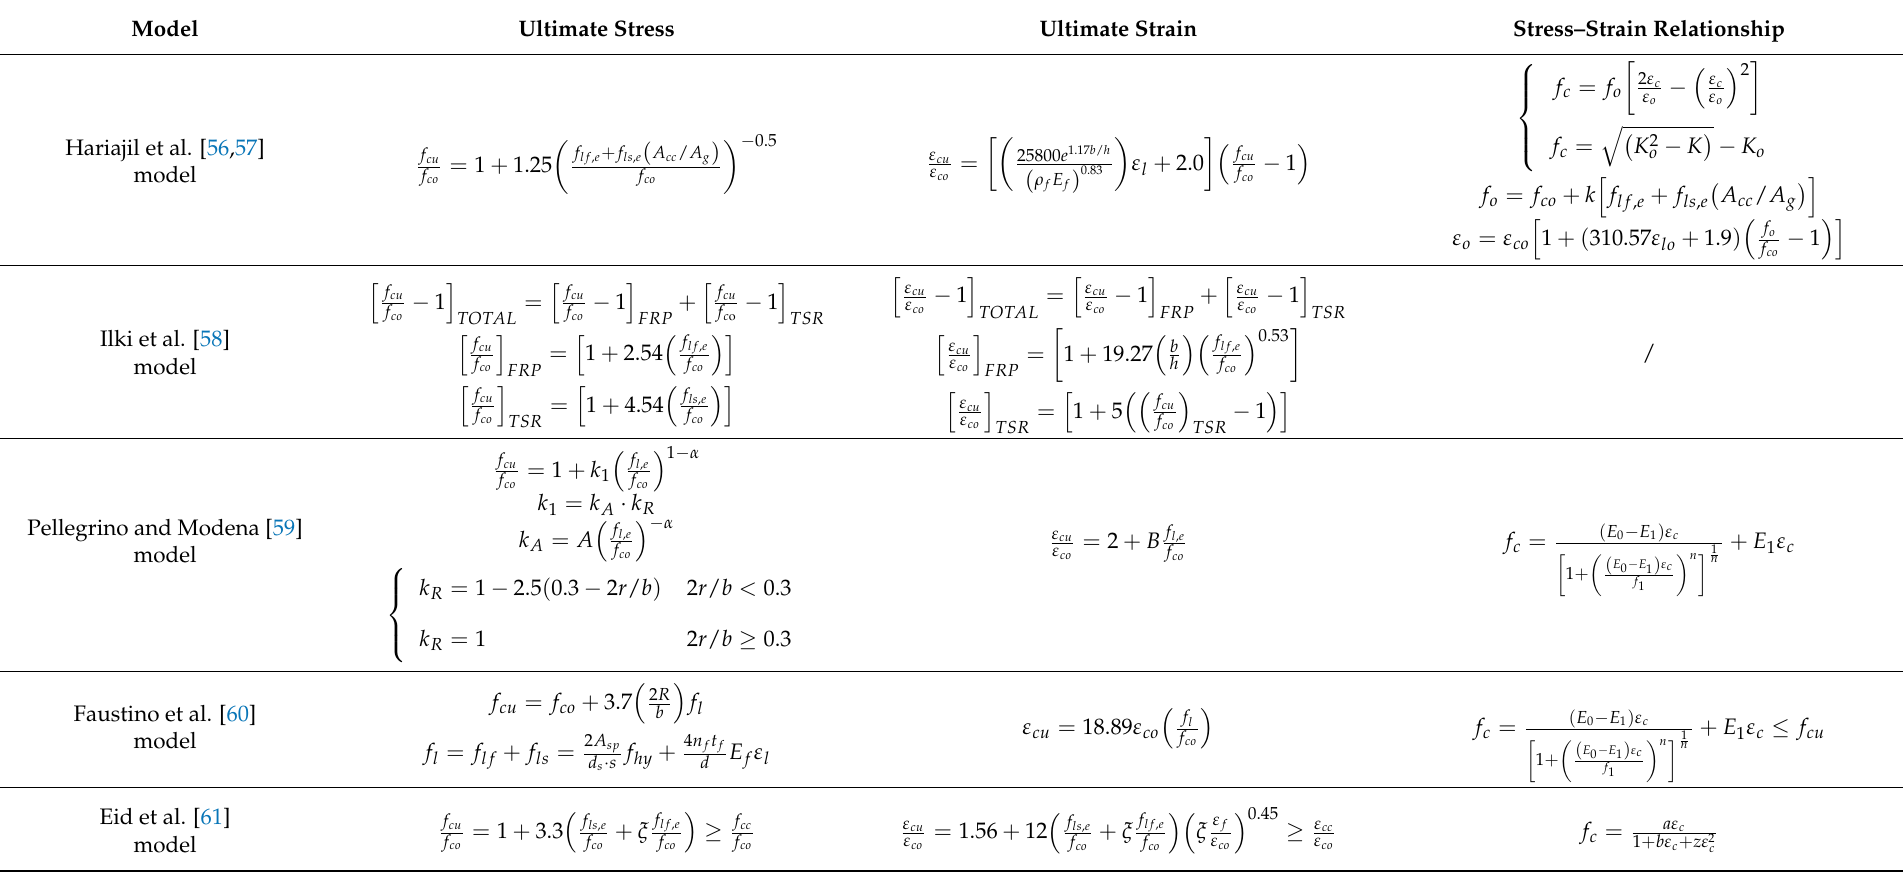
Table 2. Summary of existing FRP and stirrup-confined rectangular concrete